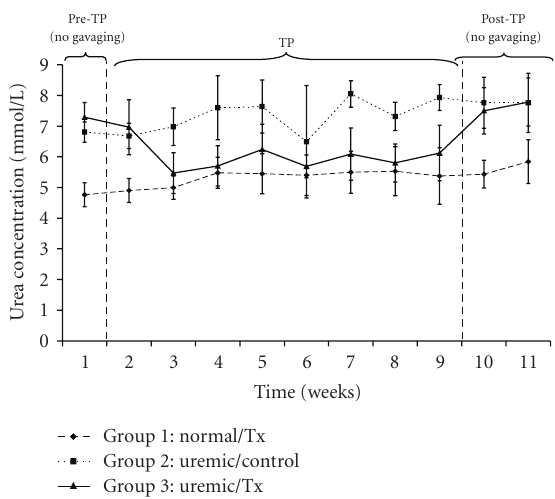
Figure 2: Plasma urea concentration before, during and after oral administration of APA microencapsulated yeast